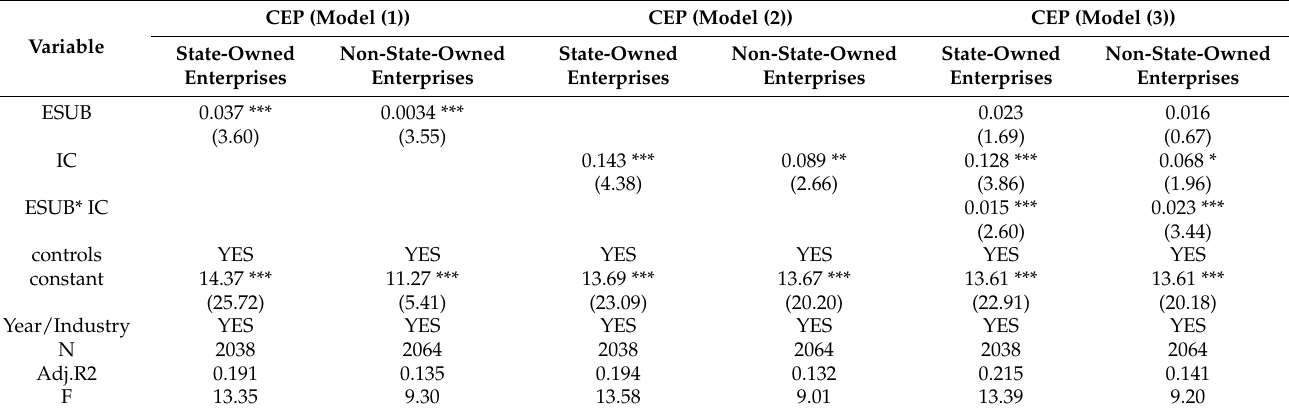
Table 6. Group regression results of state-owned enterprises and non-state-owned